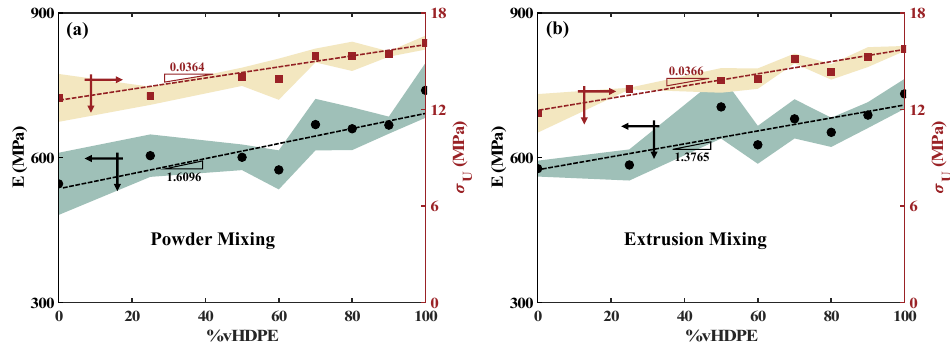
Figure 5. Effect of vHDPE content on the tensile modulus ( E ) and ultimate strength ( σ U ) of the blend for both processing methods: ( a ) powder mixing and ( b ) extrusion mixing. Standard deviations are shown as shaded areas.